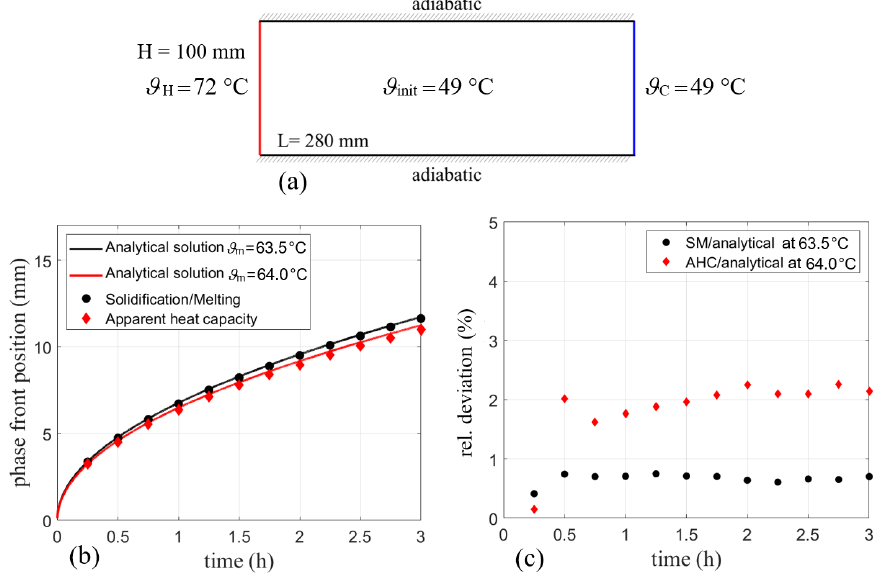
Figure 6. ( a ) Simulation domain with boundary conditions for comparison with the analytical solution of the two-phase Stefan problem. ( b ) Phase front position for SM and AHC models compared to the analytical solutions for ϑ m = 63.5°C and 64°C and ( c ) the resulting relative errors. All walls are modeled with a no-slip condition and the walls at the top and the bottom of the enclosure were considered adiabatic. Due to the symmetry of the problem, the temperature is monitored in the middle of the shown geometry over the whole length of the